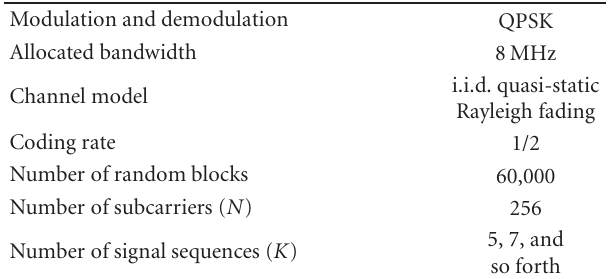
Figure 5: PAPR reduction performance of the novel SLM scheme and the conventional SLM scheme. Table 1: Simulation parameters.